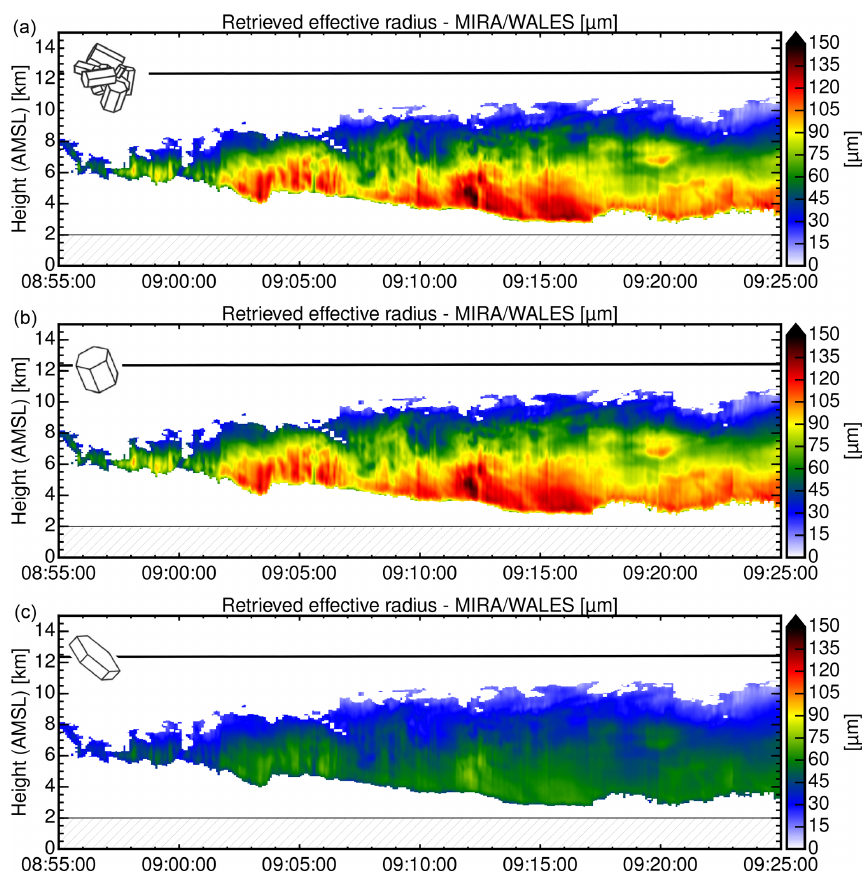
Figure A1. Effective radius of ice crystals retrieved by combining information from lidar (Fig. 7b) and radar (Fig. 7c) using the VarCloud framework and the assumption of (a) aggregates, (b) solid columns, and (c)